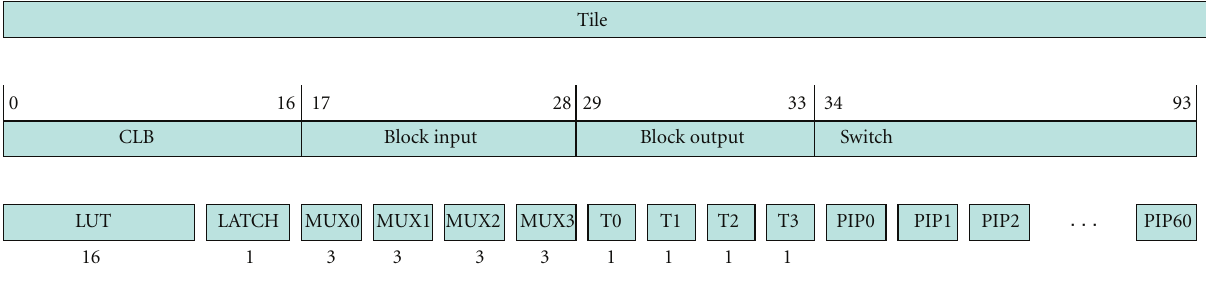
Figure 9: Example of a bitstream hierarchical